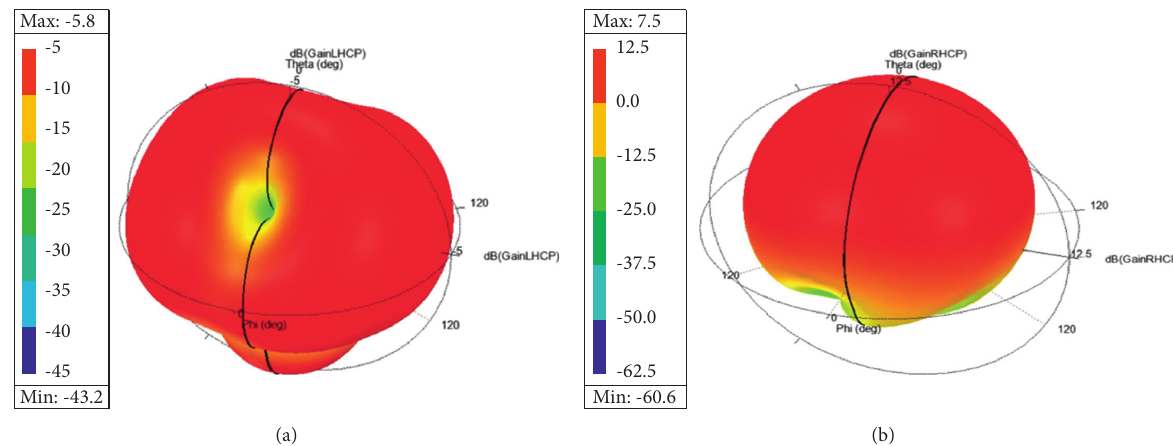
Figure 7: Simulated LHCP and RHCP gain patterns for the optimized antenna.